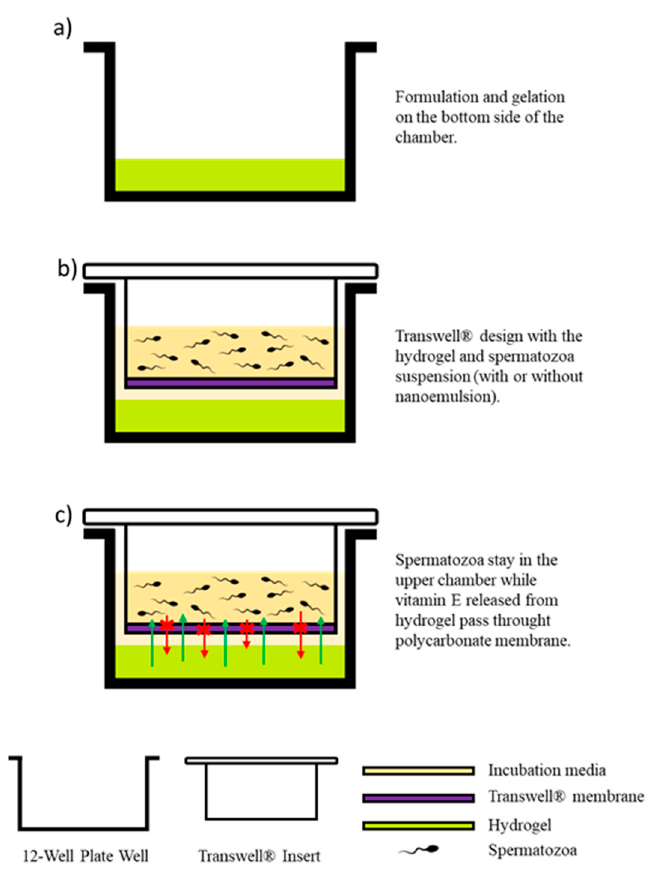
Figure 1. Design of the transwell system. ( a ) Gelation scheme on the plate well; ( b ) Sperm sample incubation into the transwell insert to avoid the mixture with the hydrogel; ( c ) Scheme of vitamin E and sperm dynamics across the polycarbonate